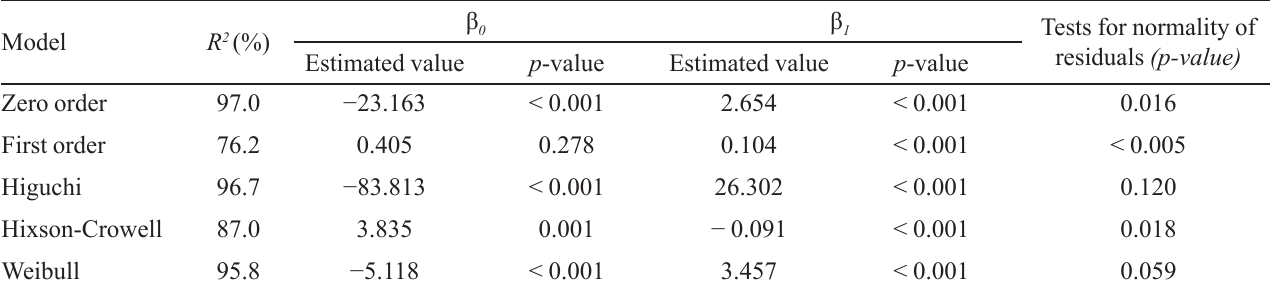
TABLE V - Results of the regression fit models for EC-MPS dissolution profile in selected medium PBS pH 6.8, using UV method, λ 250 nm